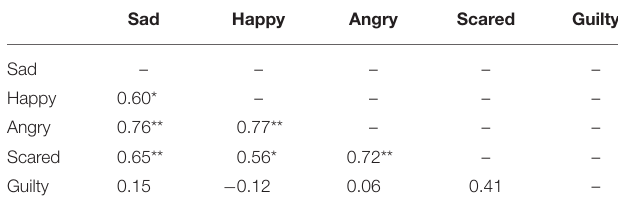
TABLE 6 | A 2 × 2 table comparing parents’ responses on the questionnaire with their performance during the storytelling task. Responses on the parent questionnaire